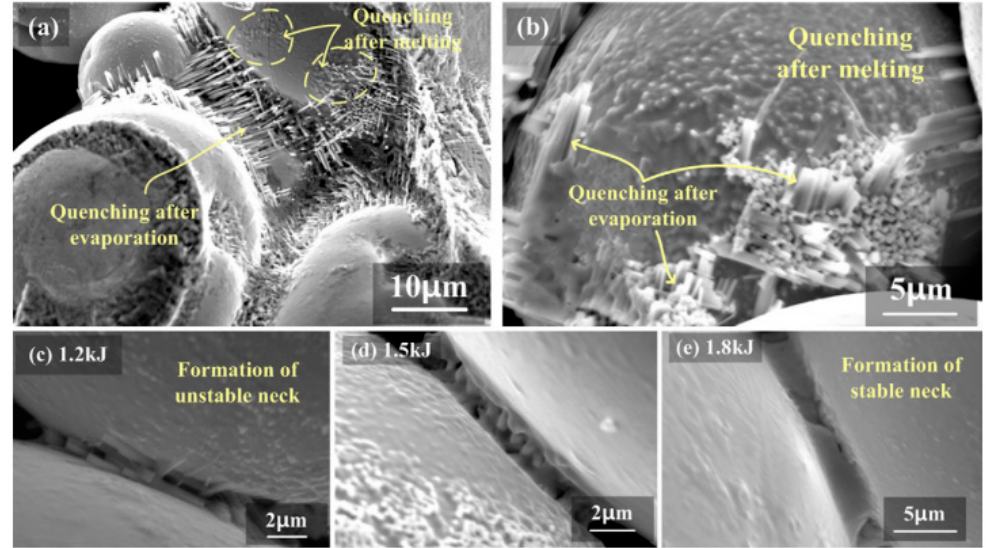
Figure 19. SEM micrographs of W compacts processed by EDC at ( a ) and ( b ) 1.5 kJ/g, and necks details for input energies of: ( c ) 1.5 kJ/g (total energy of 1.2 kJ), ( d ) 1.9 kJ/g and ( e ) 2.3 kJ/g. Reprinted with permission from ref. [123] Copyright 2012 Elsevier.